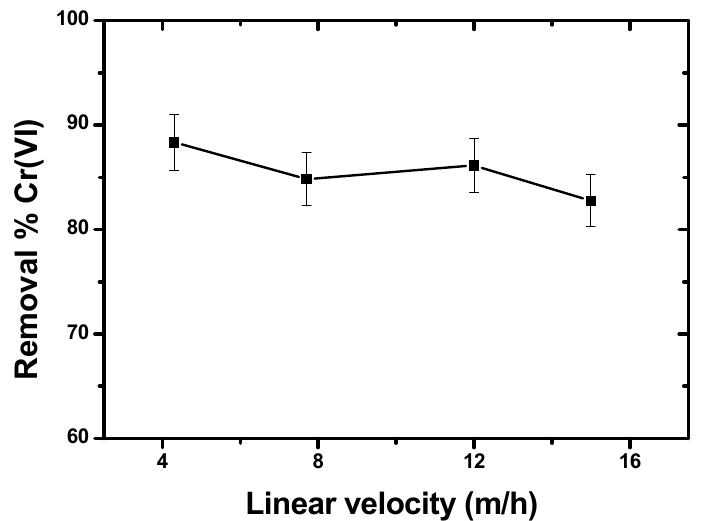
Figure 3. Removal of hexavalent chromium in relation to linear velocity. Experimental conditions: initial Cr(VI) concentration: 50 µ g / L, ferrous iron dose: 0.5 mg / L, Linear velocity values: 4, 8, 12, 15 m / h, at pH 7.3.